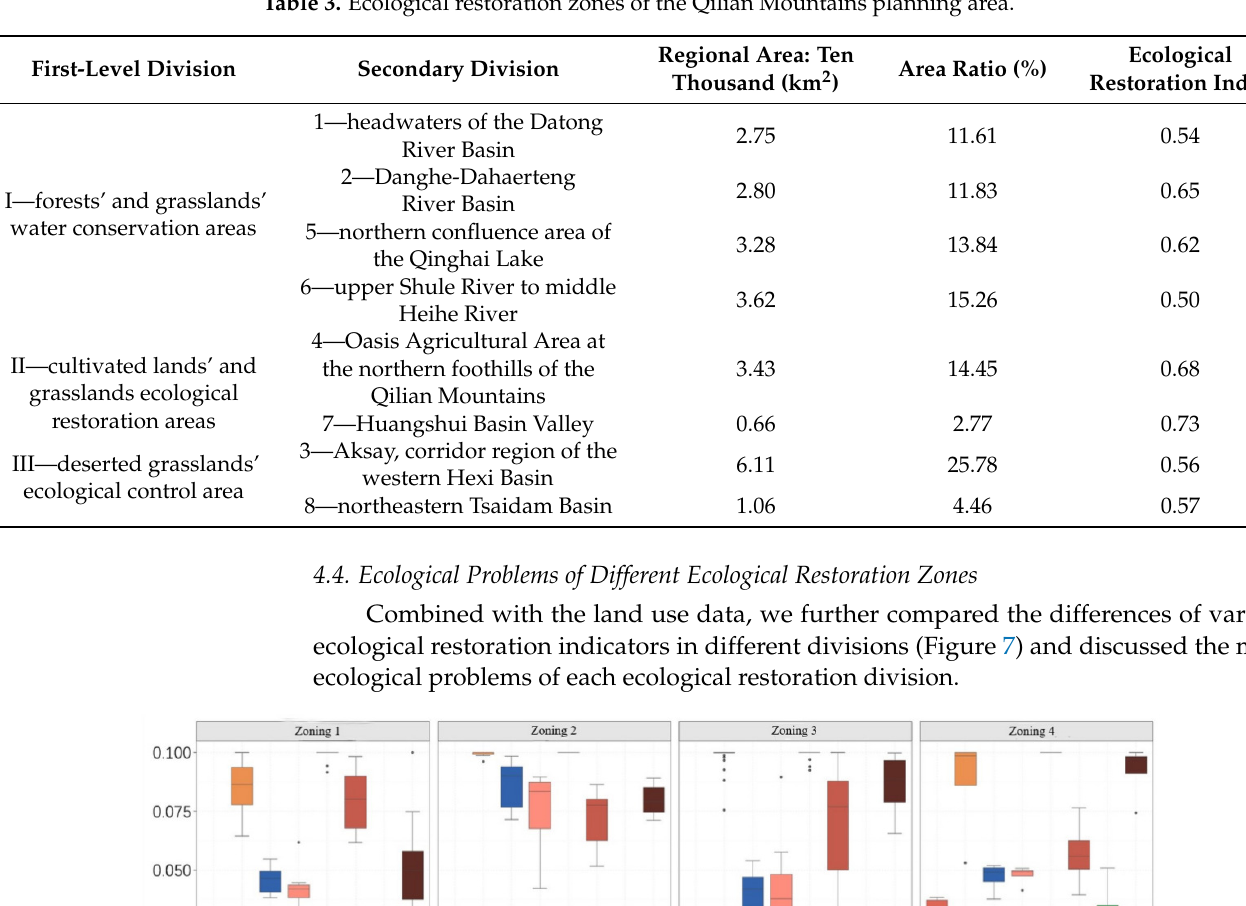
Table 3. Ecological restoration zones of the Qilian Mountains planning area.